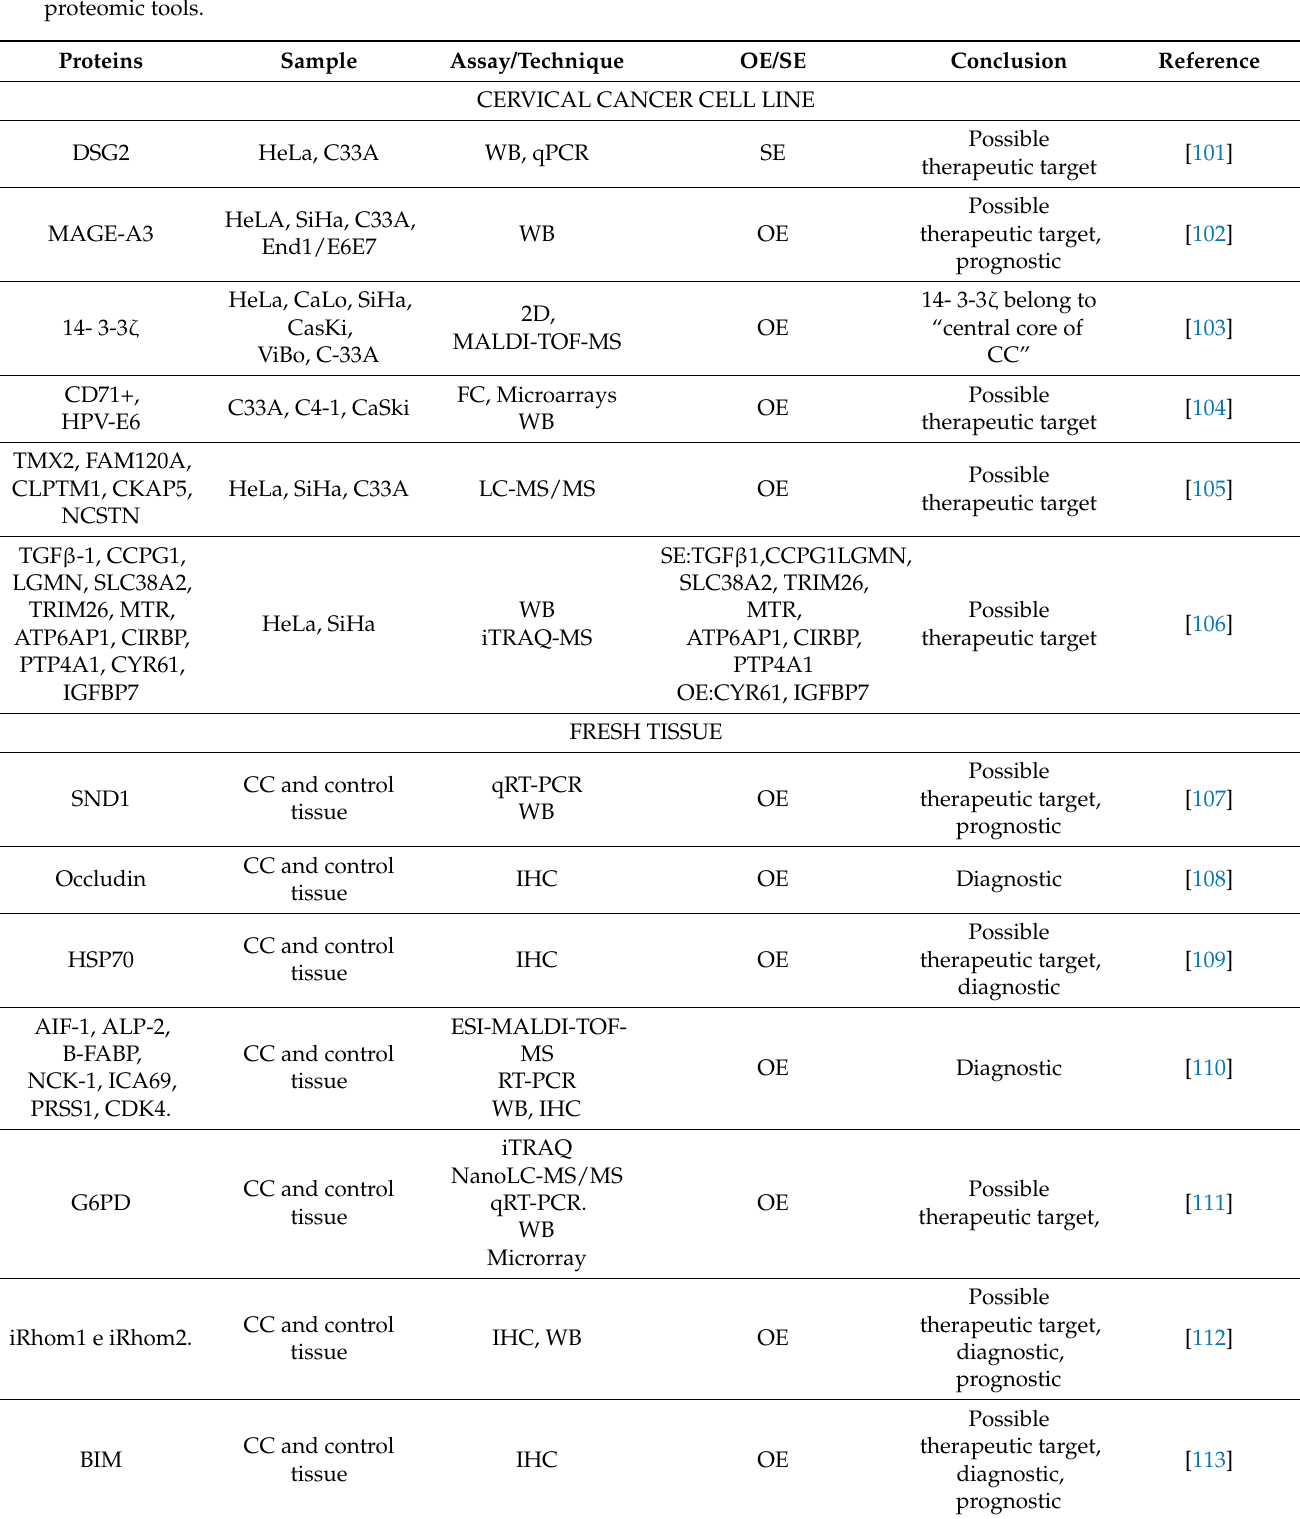
Table 2. Discovery of deregulated proteins in the different stages of CC analyzing different biological samples by proteomic